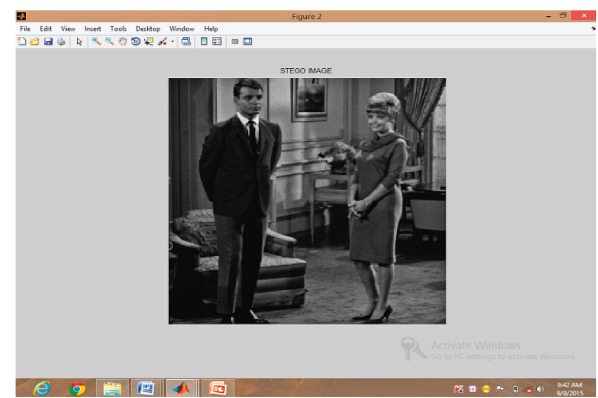
Figure 4: Stego image of couple.